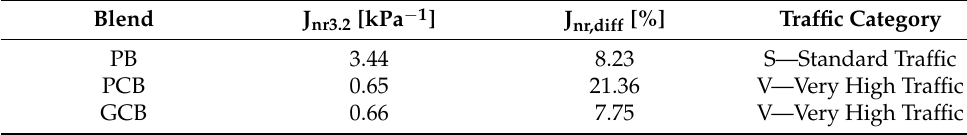
Table 7. Traffic categories in accordance with AASHTO M 332-18 Standard.